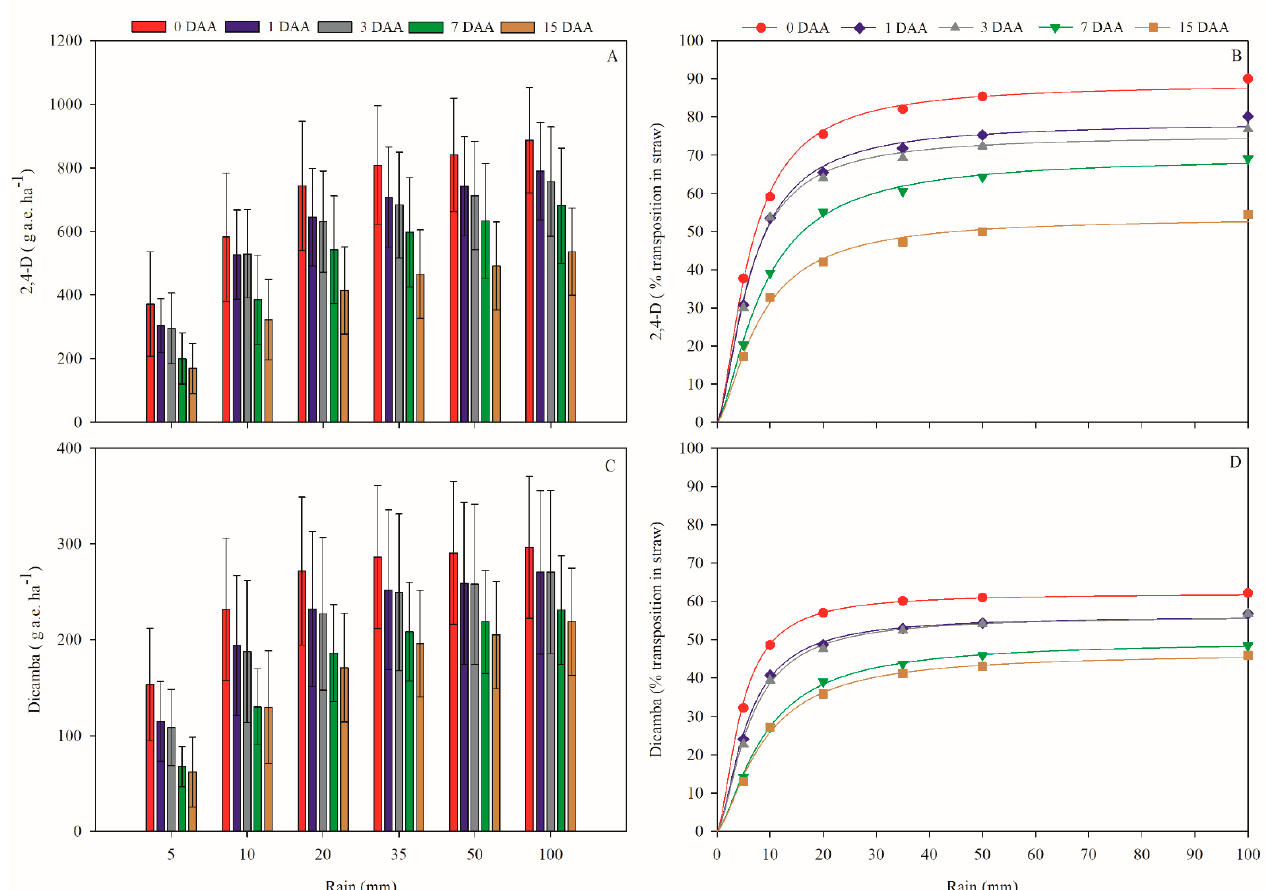
Figure 1. Dynamics of 2,4-D and dicamba in corn straw at g a.e. ha − 1 ( A , C ) and percentage ( B , D ) of herbicides leached into the straw in relation to the total amount deposited after rainfall simulations (5, 10, 20, 35, 50, and 100 mm) in different periods after herbicide application (0, 1, 3, 7, and 15 days after application—DAA). The error bars represent the confidence interval ( p ≤ 0.05).